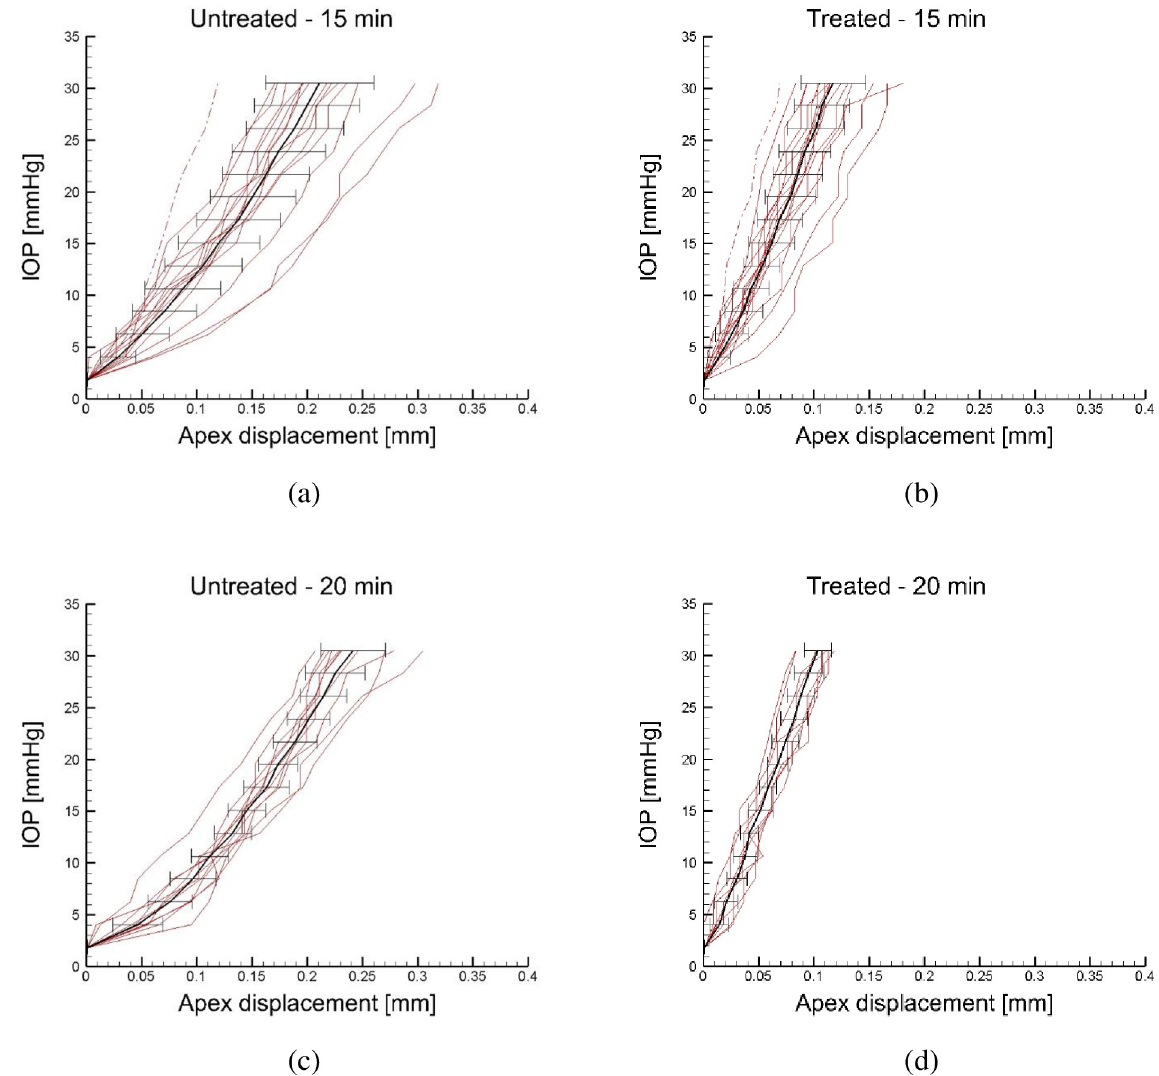
Fig 6. Inflation tests for the cornea groups irradiated for longer times, 15 and 20 minutes, respectively. IOP versus apex displacement: comparison between the untreated corneas and the treated corneas. Average values and error bars are also